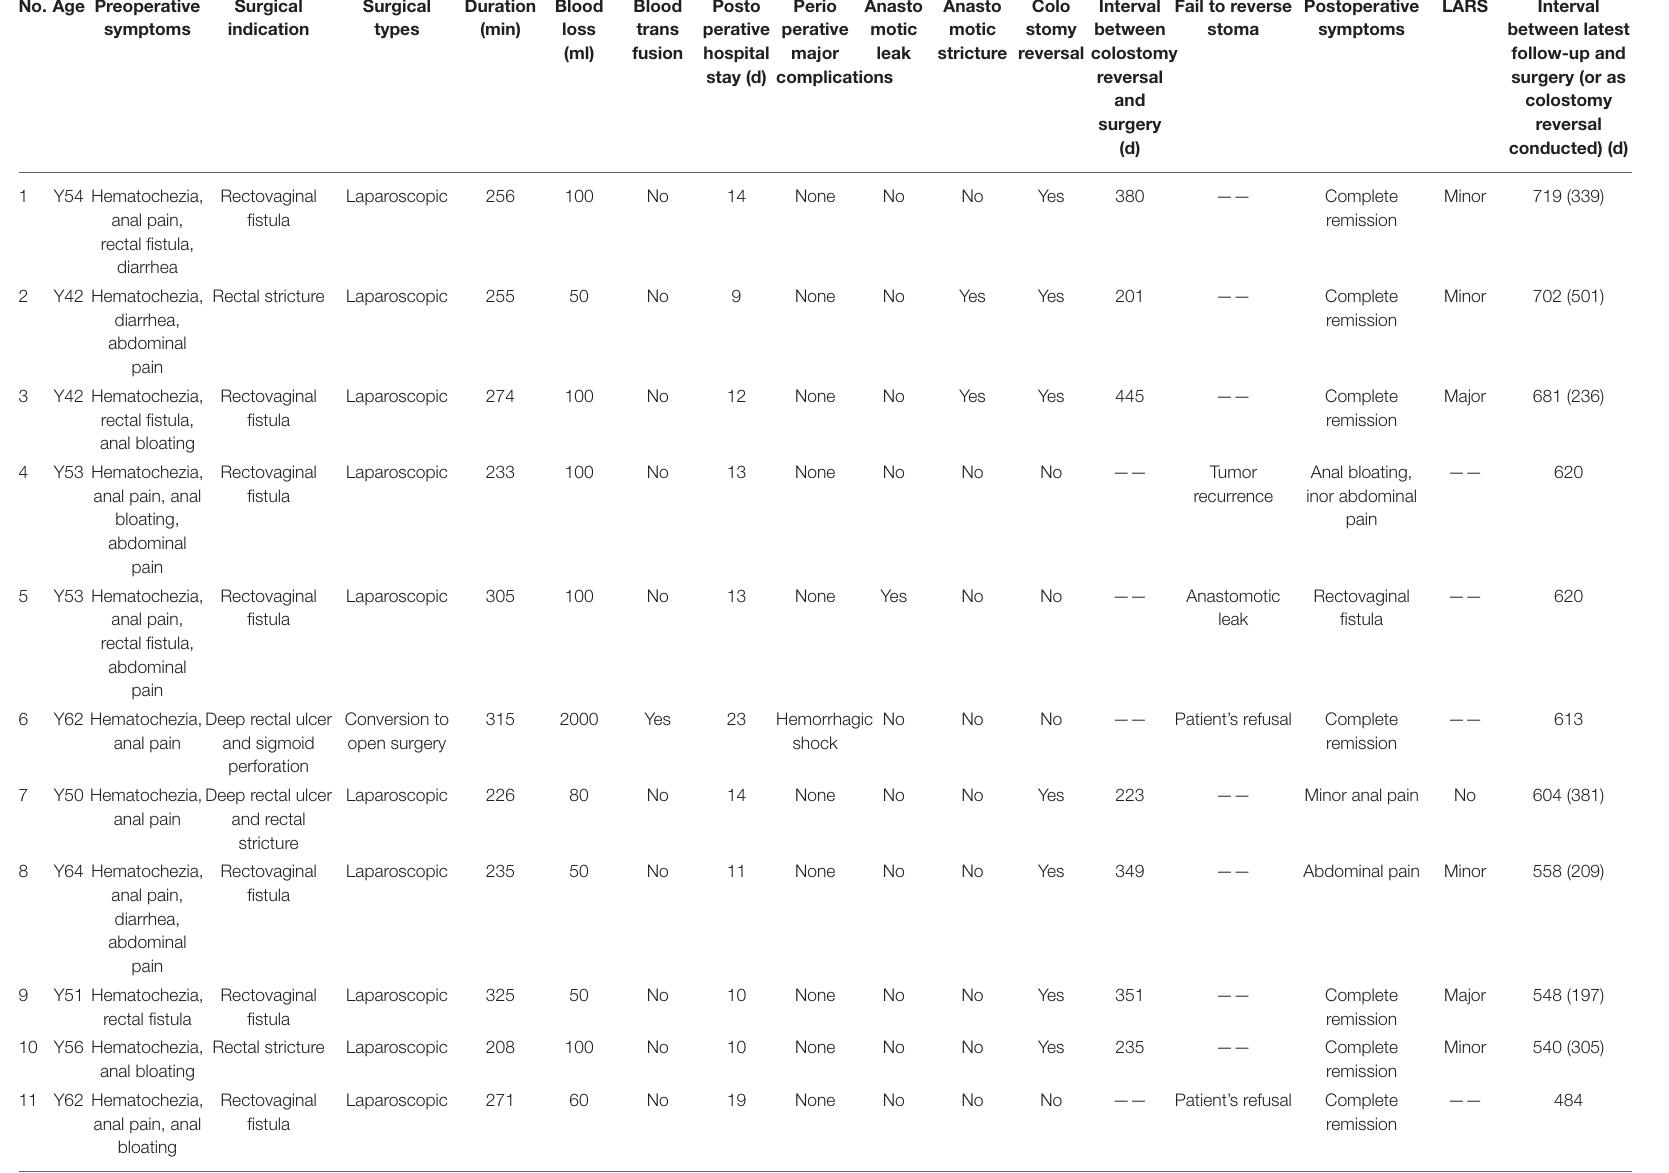
TABLE 4 | Details of surgery, perioperative recovery, and